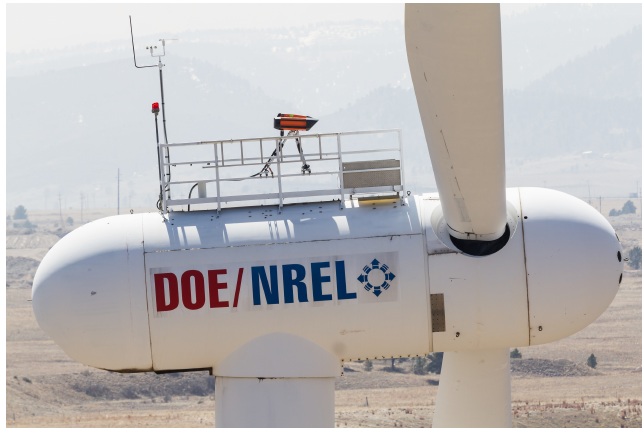
Figure 9. The pulsed LiDAR mounted on the three-bladed Controls Advanced Research Turbine located at the National Wind Technology Centercite in Boulder, Colorado [135]. Photo credit: Lee Jay Fingersh, National Renewable Energy Laboratory